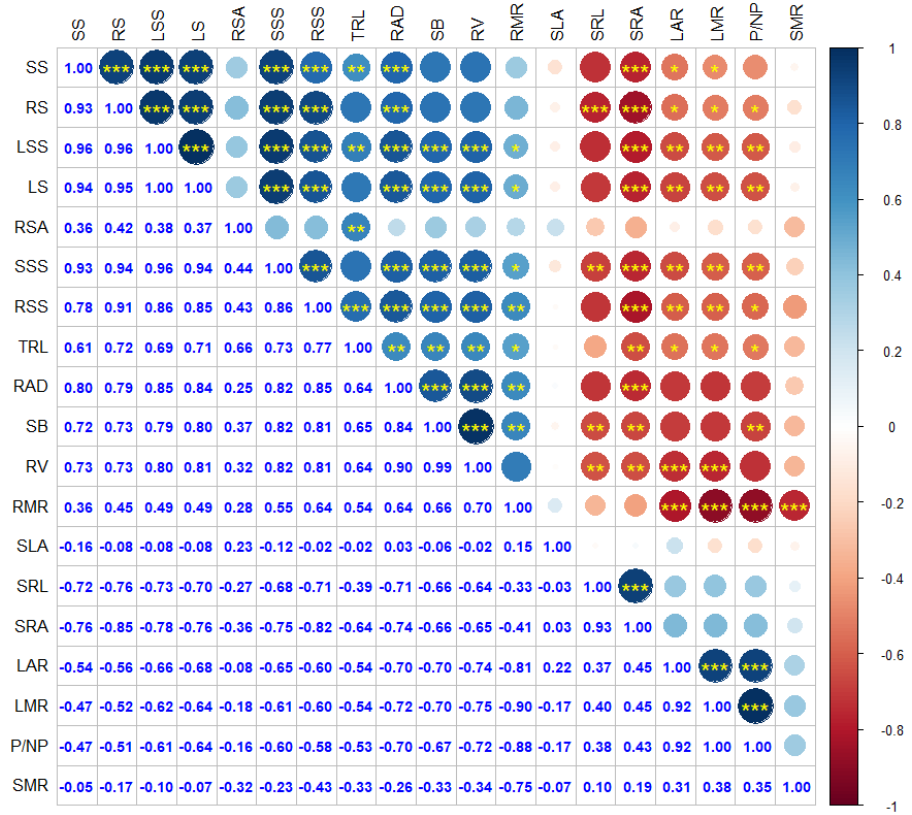
Figure 8. Correlations among seedling characteristics of Quercus acutissima. SB: seedling biomass; LMR: leaf mass ratio; RMR: root mass ratio; SMR: stem mass ratio; SLA: specific leaf area; LAR: leaf area ratio; TRL: total root length; RSA: root total surface area; RV: root volume; RAD: root average diameter; SRL: specific root length; SRA: specific root area; P/NP: photosynthetic tissues/non-pho- tosynthetic tissues; RSS: root soluble sugar; SSS: stem soluble sugar; LSS: leaf soluble sugar; RS: root starch; SS: stem starch; LS: leaf starch. Significant code: *** p < 0.001, ** p < 0.01, * p < 0.05 . The PCA incorporating seedling traits revealed that together, the first and second principal components represented 74.15% of the total variation (Figure 9). The first prin- cipal component (62.65%) was mainly related to seedling growth, including SB, NSC (SS, SSS, LSS, RS, SS, and LS), and root traits (RV, TRL, RAD, RSA, SRL, and SRA). The second principal component (11.5%) was associated with biomass allocation, including SMR, LMR, LAR, P/NP, SLA, and RMR.